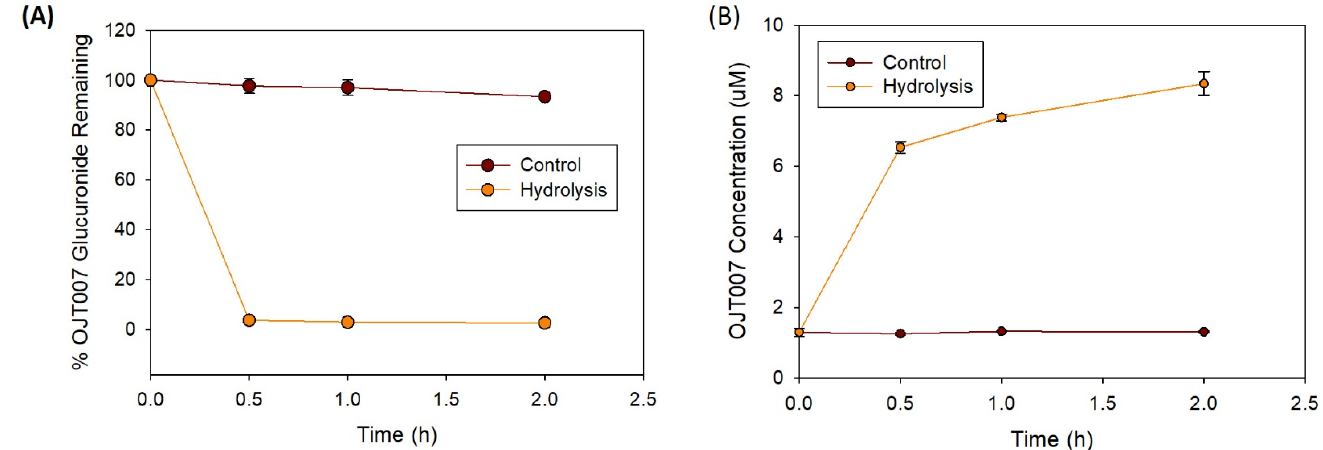
Figure 9. Hydrolysis of OJT007 glucuronide generated by rat liver microsomes with E.Coli β - glucuronidase. ( A ) Remaining glucuronide metabolite after hydrolysis. ( B ) OJT007 concentration after hydrolysis. Each data point indicated the mean ± SD.